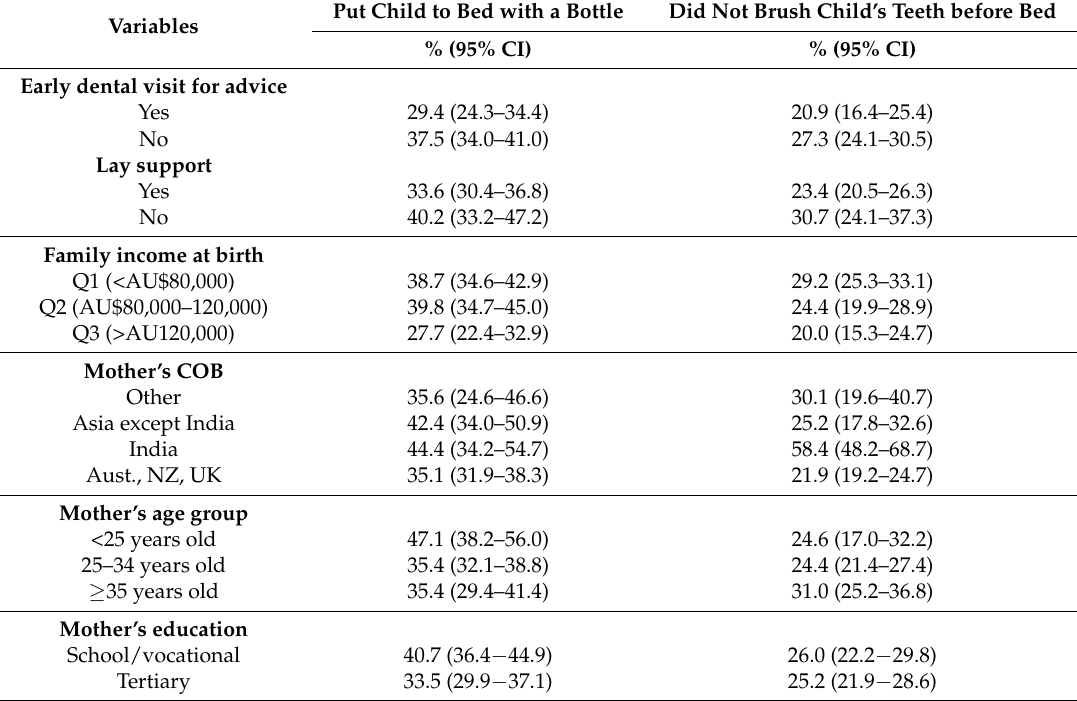
Table 2. Bivariate associations of unfavourable dental health behaviour with exposures and